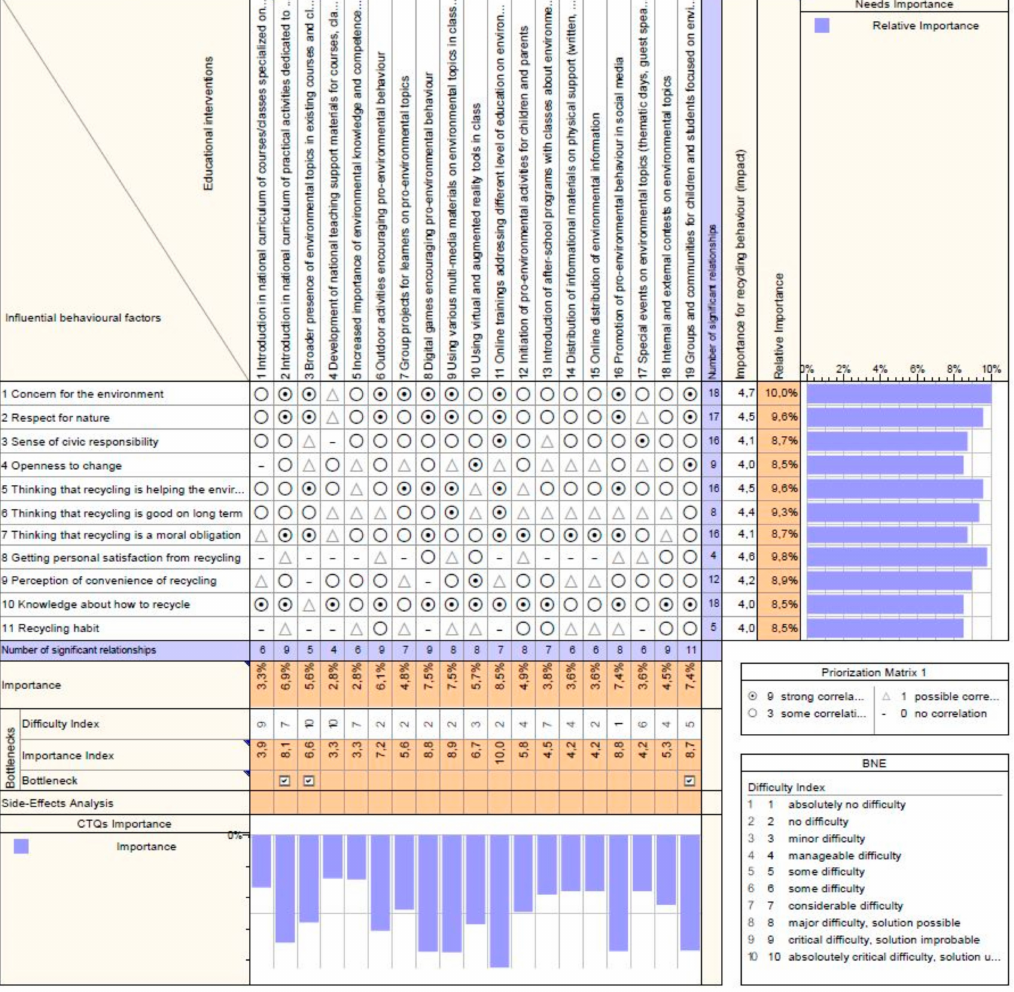
Figure 3. Correlation Matrix for interventions addressing learners—output from the Qualica QFD